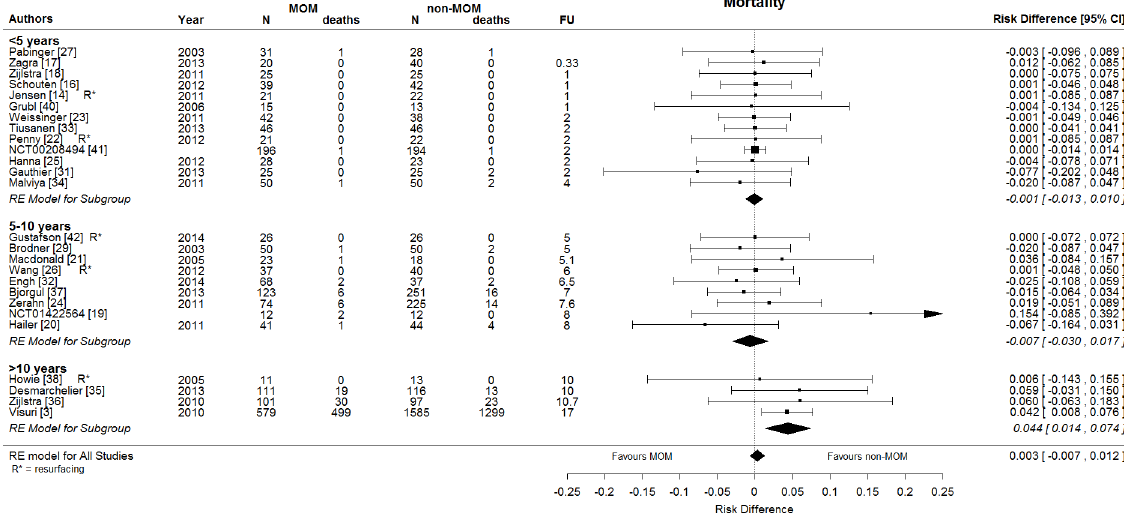
Fig 2. Forest plot showing the risk difference in mortality between MOM THA and non-MOM THA. Overall, there is no difference in mortality between MOM THA and non-MOM THA. After 10 years, there is an increased risk of mortality for MOM THA. Besides one observational study [3] of first generation MOM all other studies are RCTs. RE model = random effects